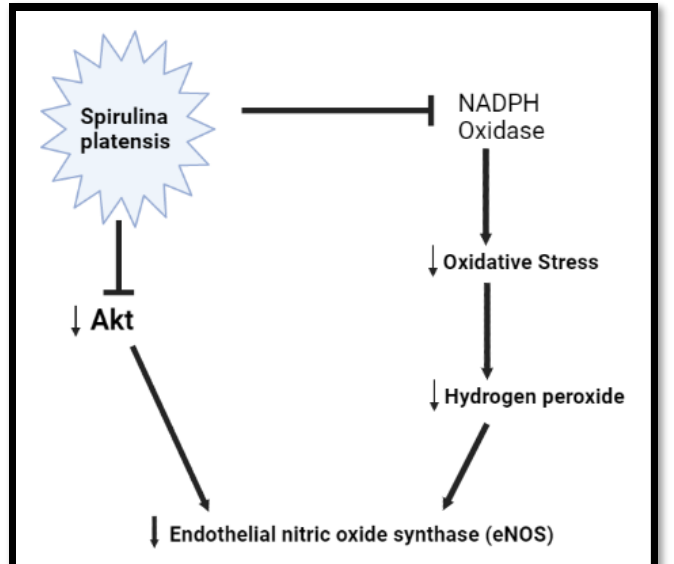
Figure 3. Diagrammatic representation of Spirulina platensis reduction of oxidative stress via inhibition of NADPH oxidase, leading up to eNOS mRNA downregulation. Spirulina platensis inhibits NADPH oxidase, reduces ROS, and blocks free radical species including H 2 O 2 , leading to the reduction of oxidative stress and reduced demand for eNOS (created with BioRender.com).